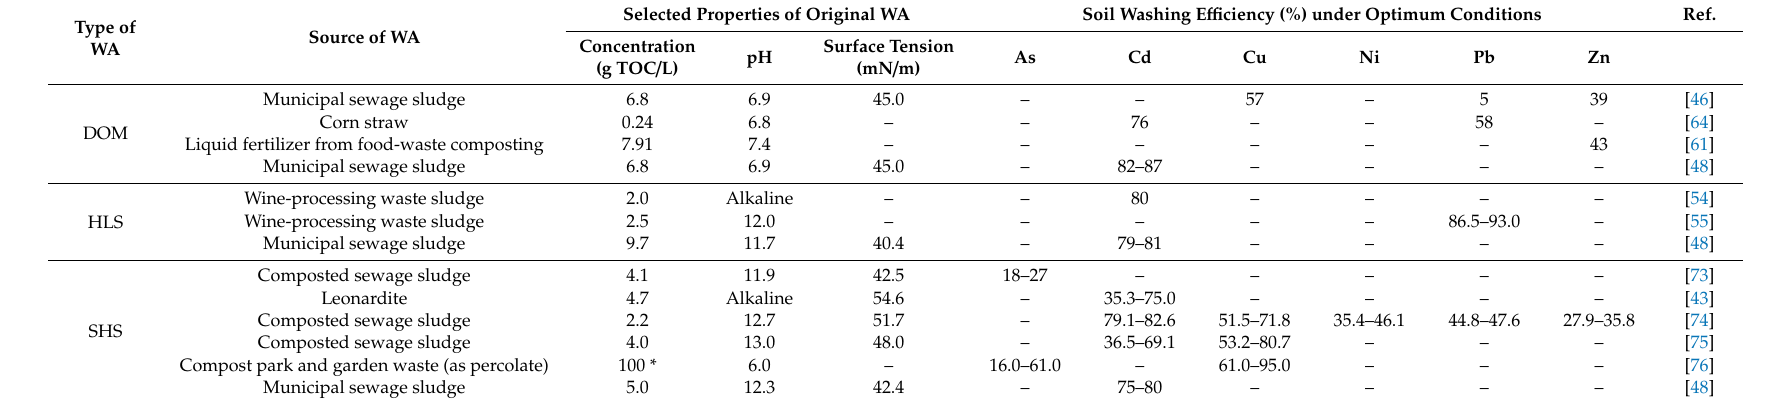
Table 3. Selected properties of WAs isolated from wastes and their e ffi ciency in HM removal from